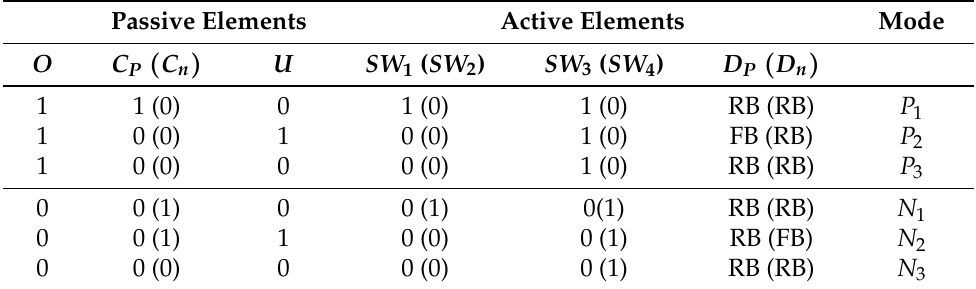
Table 2. Components operational status at each mode.